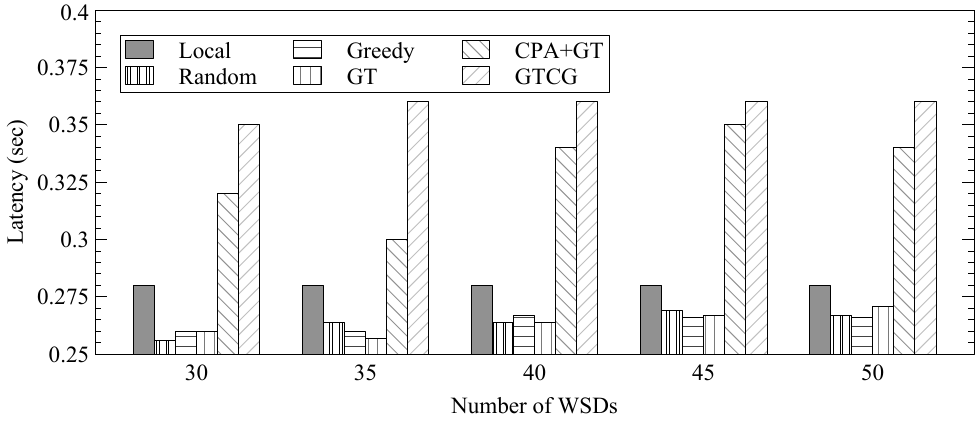
Figure 5. Average Latency for Different Number of